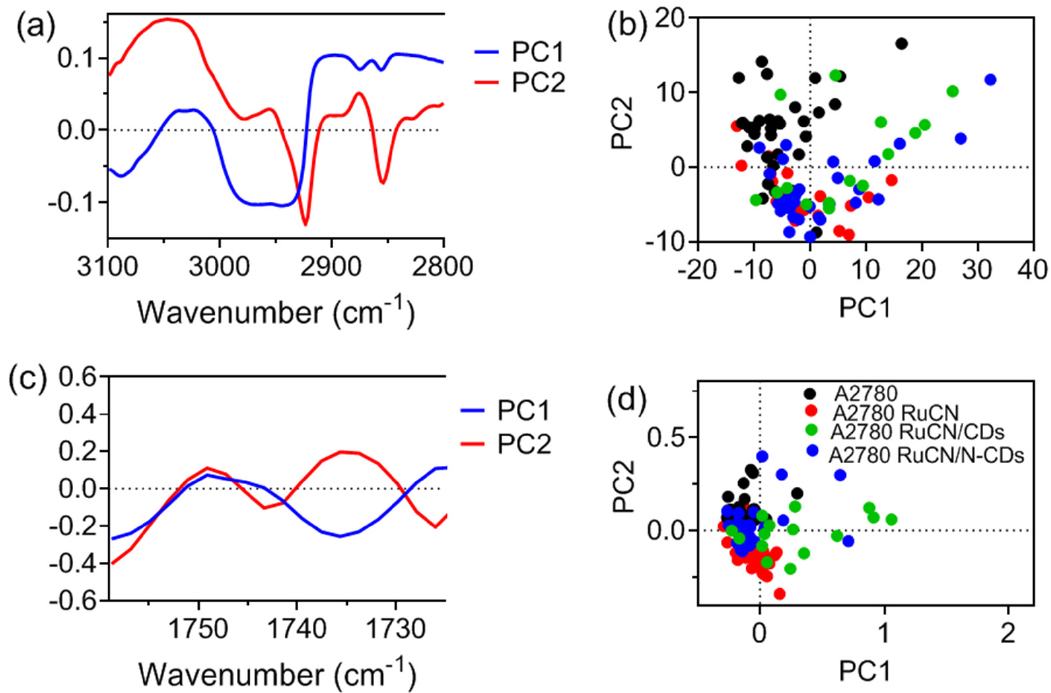
Figure 7. PCA loadings of the first two components (PC1 and PC2) of ν (C–H) vibration region ( a ) and corresponding PCA score plot ( b ). PCA loadings of the first two components (PC1 and PC2) of ν (C=O) vibration region of lipids ( c ), and corresponding PCA score plot denote the variability associated with the first two components ( d ).